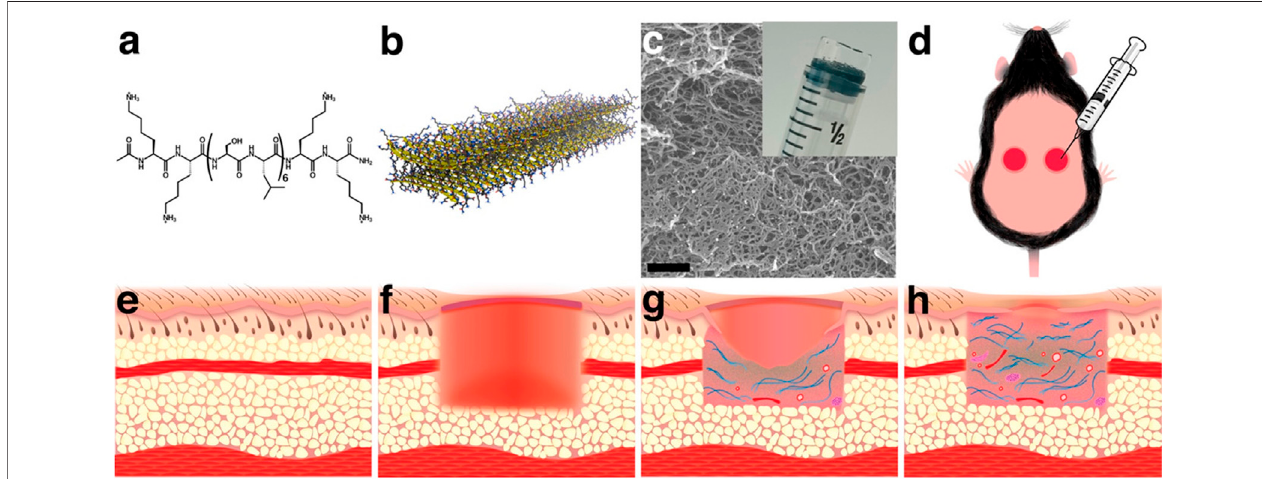
FIGURE 7 | Multidomain peptide (MDP) forms a nano fi brous hydrogel that is easily applied to wounds in a diabetic mouse model. (A) 16-amino acid MDP, K2(SL) 6K2, forms (B) nano fi bers through the hydrophobic effect and hydrogen bonding. (C) Nano fi bers cross-link with multivalent salts to form a hydrogel. (D) Because the hydrogel is syringe deliverable, it can be easily applied to wounds and conforms to their shape. (E) Before creation of the wound, the subcutaneous tissue is fi lled with adipose tissue and the panniculus carnosus muscle layer. (F) Wounding ofthe dorsal tissueremovesepithelium, adipose tissue, and the panniculus carnosus. (G) As the wound heals granulation tissue, collagen, blood vessels, and neural fascicles fi ll the wound bed and epithelial cells migrate across the granulation tissue creating epithelial tongues. (H) Over time, the amount of granulation tissue, collagen, blood vessels, and neural fascicles increase, and the epithelial tongues extend to close the wound (Carrejo et al., 2018). Images were adapted with permission from Carrejo et al. (2018). Copyright 2018, American Chemical